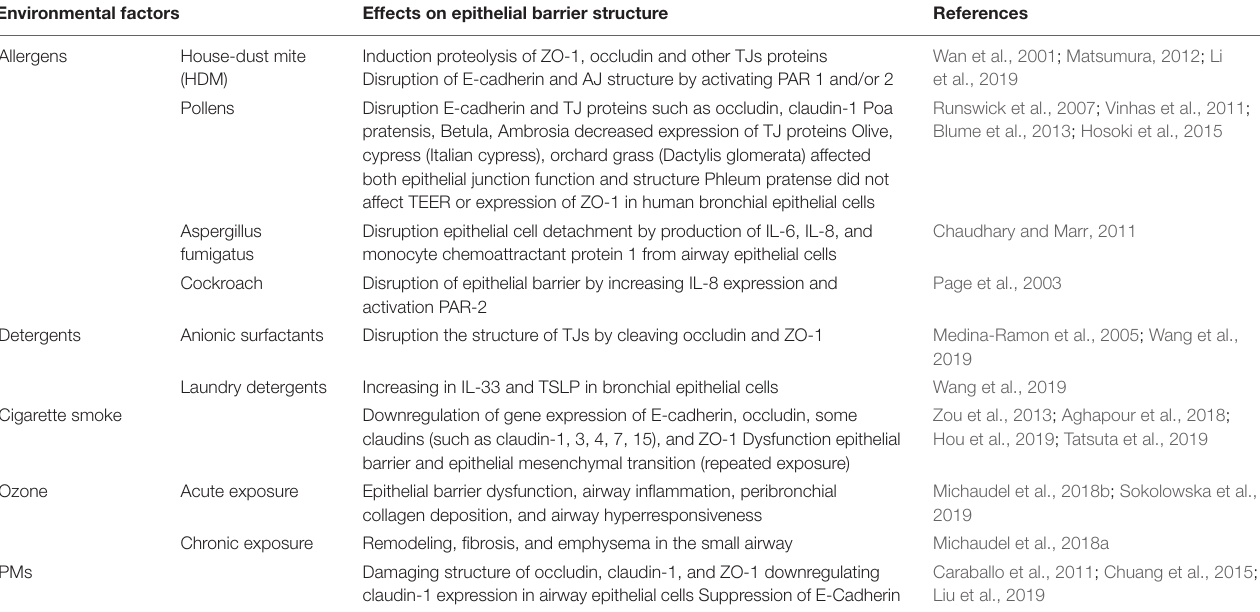
TABLE 1 | The effect of environmental factors on the epithelial barrier